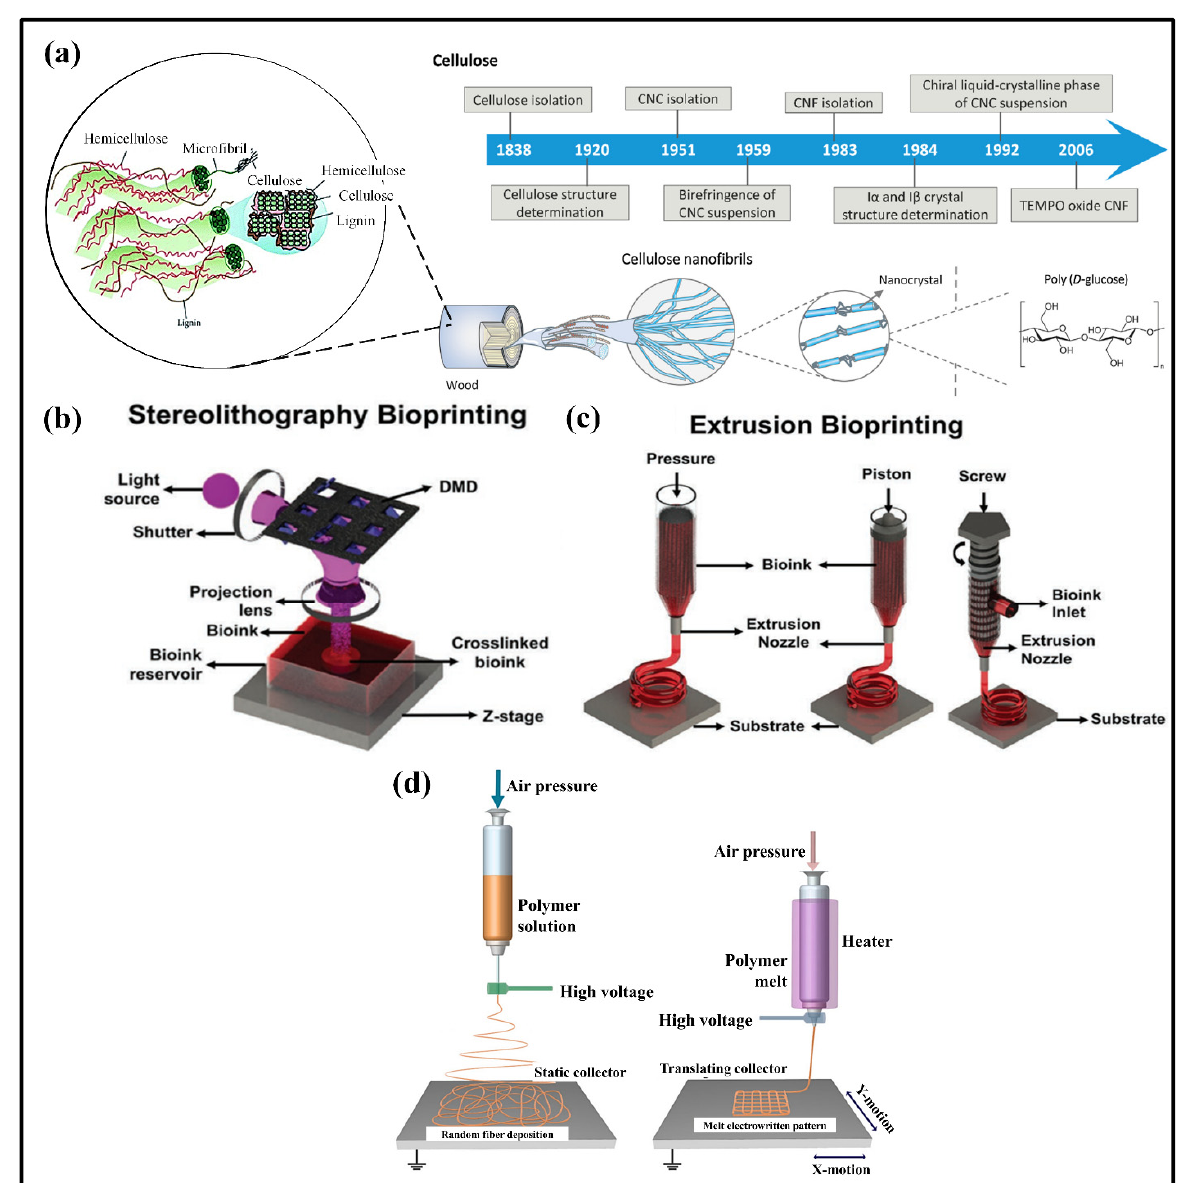
Figure 3. ( a ) Cellulose nanocrystals discoveries milestone in the structural characterization and preparations. Adapted with permission from Ref. [143]. ( b ) Stereolithography (SLA) printing, ( c ) Extrusion bioprinting. Adapted with permission from Ref. [144]. ( d ) Solution and melt electrowriting technique. Adapted with permission from Ref. [145].